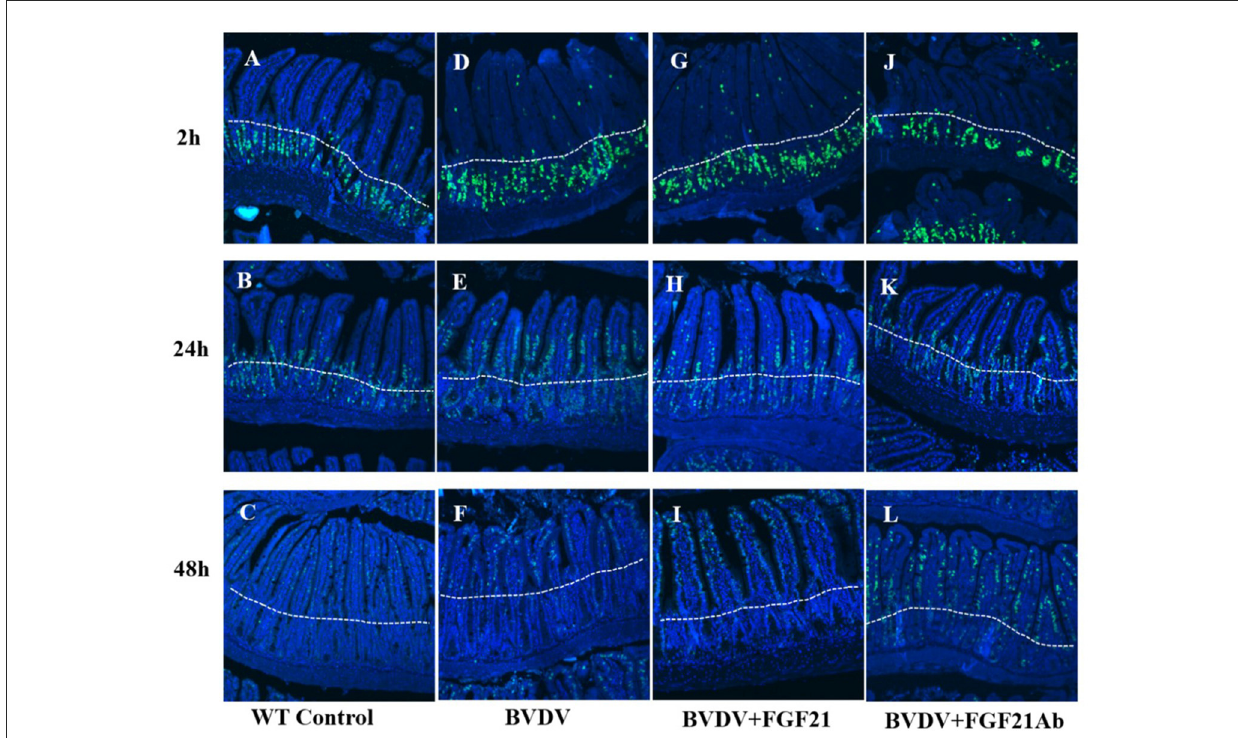
FIGURE7 BrdU staining of mouse duodenal epithelial cells. (A–C) BrdU staining results at 2 h (A) , 24 h (B) , and 48 h (C) in the control group. (D–F) BrdU staining results at 2 h (D) , 24 h (E) , and 48 h (F) in the BVDV group. (G–I) BrdU staining results at 2 h (G) , 24 h (H) , and 48 h (I) in the FGF21 group. (J–L) BrdU staining results at 2 h (J) , 24 h (K) , and 48 h (L) in the BVDV+FGF21Ab group.